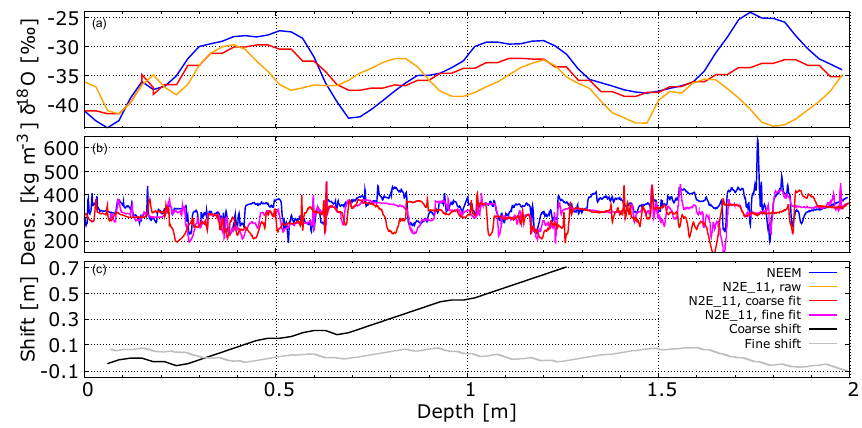
Figure 4. Alignment of the data from NEEM and N2E_11. (a) First, the raw δ 18 O data from N2E_11 (orange) are fit to those of NEEM (blue) resulting in the red curve. (b) Then, the calculated (coarse) shifts are applied to the raw N2E_11 density data to obtain the red curve as an input for a second alignment with the raw NEEM density profile (blue). We end up with the pink curve as a final result. (c) The applied coarse (black) and fine (gray) shifts.